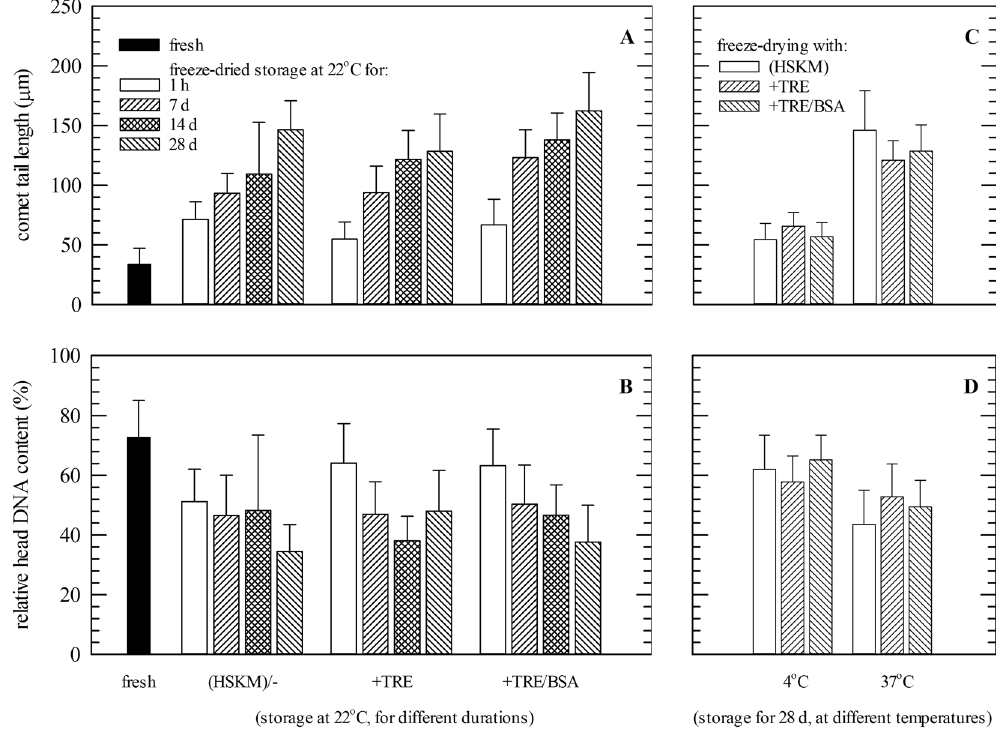
Figure 6. DNA damage during dried storage of fibroblasts was evaluated using the ‘comet assay’. Fibroblasts were freeze-dried in saline solution without supplements (HSKM) or with trehalose or trehalose/albumin. Storage was done for different durations at room temperature ( A , B ) as well as at different temperatures for 1 month ( C , D ). Analysis was done prior to freeze-drying (black bars), directly after freeze-drying (white bars) and after 1–4 weeks storage at room temperature (7 d: bars with upward diagonals, 14 d: bars with diamonds, 28 d: bars with downward diagonals) ( A , B ). Furthermore, specimens were analyzed after 28 d storage at 4 °C and 37 °C (without supplements: white bars, with trehalose: bars with upward diagonals, with trehalose/albumin: bars with downward diagonals) ( C , D ). From microscopic images of Hoechst-stained specimens, both the comet tail lengths were determined ( A , C ) and relative DNA contents (i.e. Hoechst fluorescence) in comet heads versus tails ( B , D ). Mean values ± standard deviations were determined from two independent experiments, and a minimum of 30 ‘comets’ were analyzed per